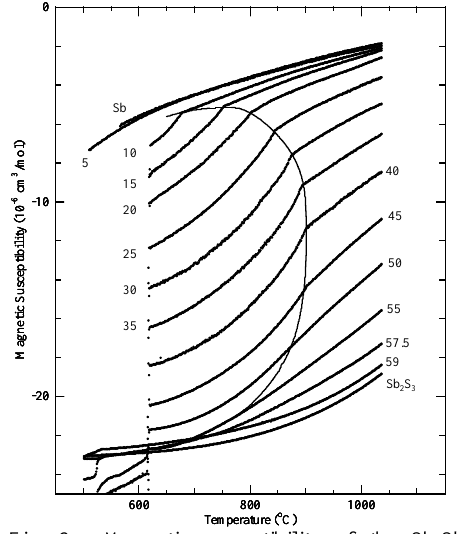
Fig. 2. Magnetic susceptibility of the Sb-Sb 2 S 3 system. Smooth curve is the magnetic susceptibility along the phase boundary explained in the text. Numbers indicate at.% S.